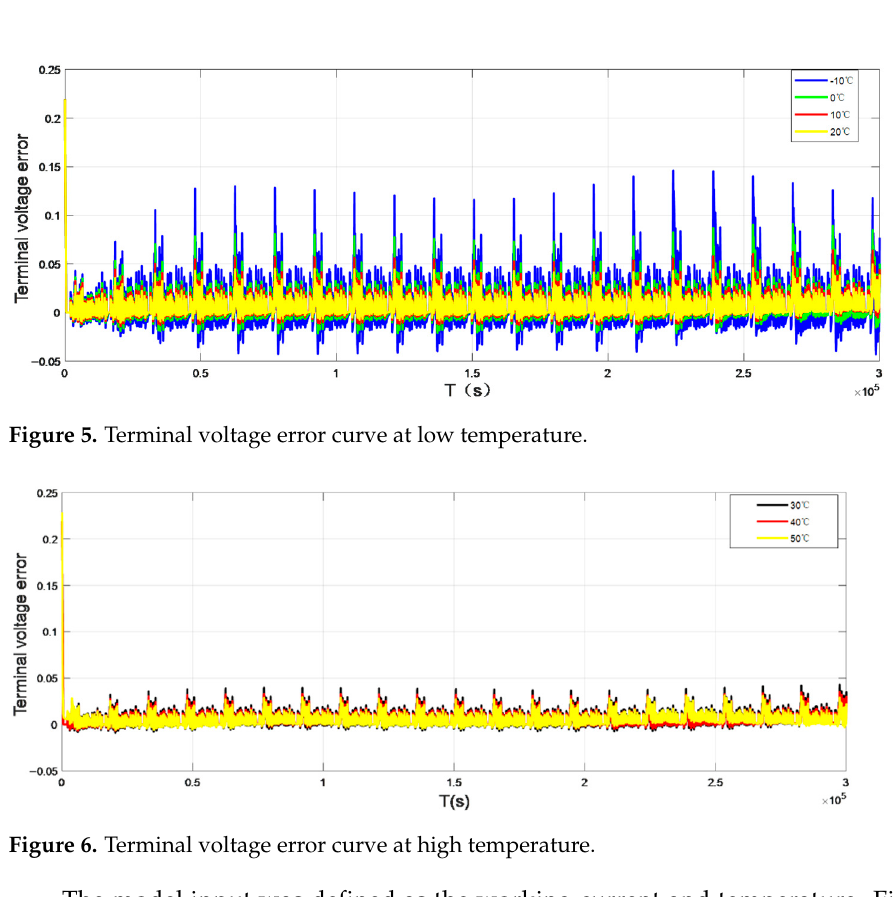
Figure 4. Terminal voltage error curve at 25°C.